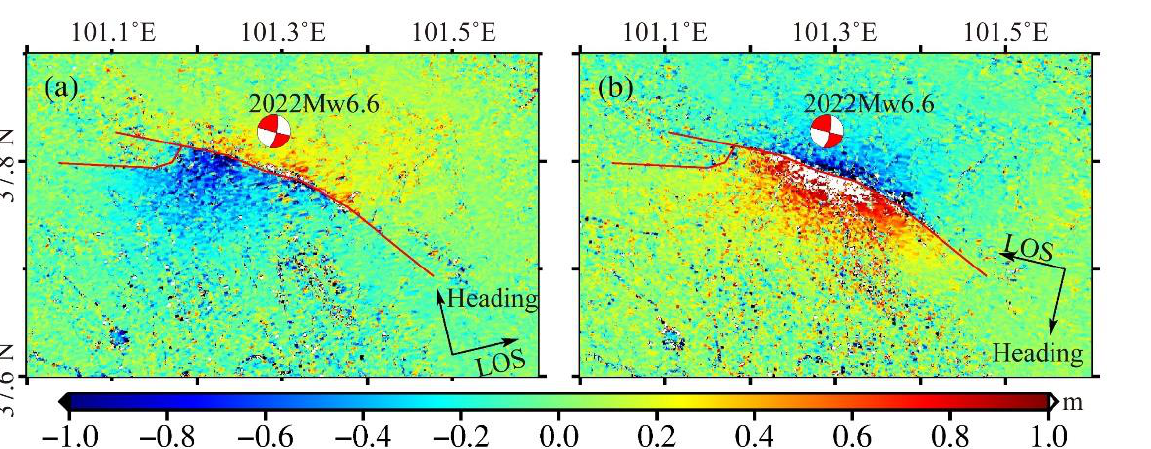
Figure 4. The collage of InSAR coseismic displacement field of the 2016 and 2022 Menyuan earth- quakes. ( a , c ) the wrapped interferograms on ascending and descending tracks. ( b , d ) the correspond- ing unwrapped displacement fields. The dashed black lines represent the profile locations. The black solid rectangle in ( a ) outlines the extent shown in Figure 4e. ( e ) the close-view of displacement field of the 2022 event. The pink dots are the relocated aftershocks triggered by the 2022 event [28]. The green lines present the surface rupture trace from the field investigation [19]. The blue lines represent the InSAR-derived fault trace [20]. The black cross is the surface rupture interpreted by Gaofen-7 images [33]. The red lines present the surface trace of the two-fault model for the 2022 event in this study. ( f ) the coseismic displacement profiles along aa’ and bb’ with locations shown in Figure 4b,d. The blue and red dots represent the coseismic displacement data of the ascending and descending tracks, respectively.